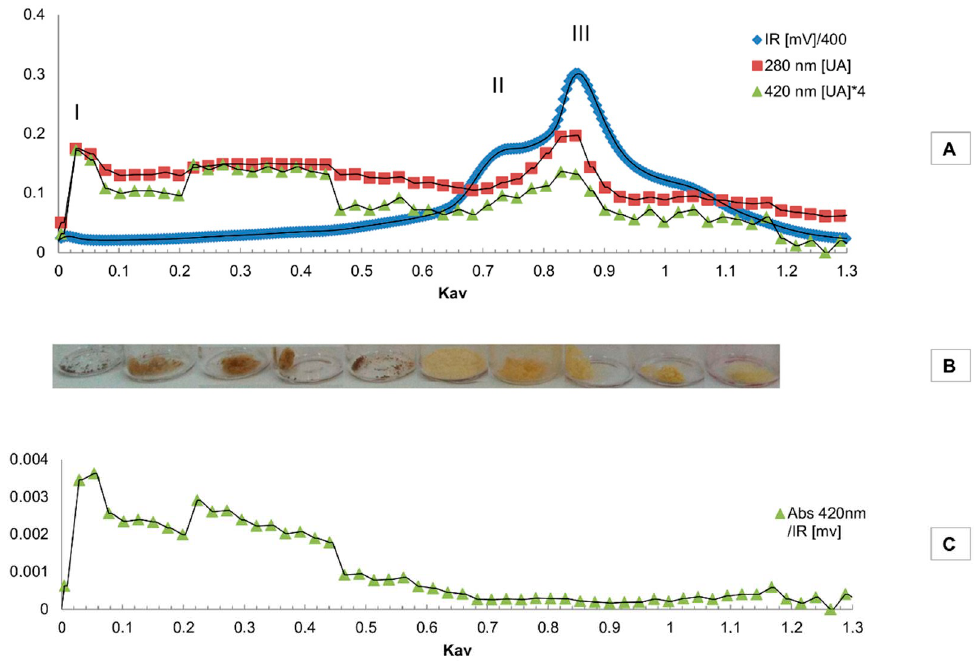
Figure 5. Size exclusion chromatography of IHS. IR and UV-VIS detection ( A ) and absorbance ( λ 420 nm) to IR signal ratio ( C ) chromatograms. The image of the fractions is shown in ( B ). Pooled fractions mentioned in the text are indicated as I, II, and III.